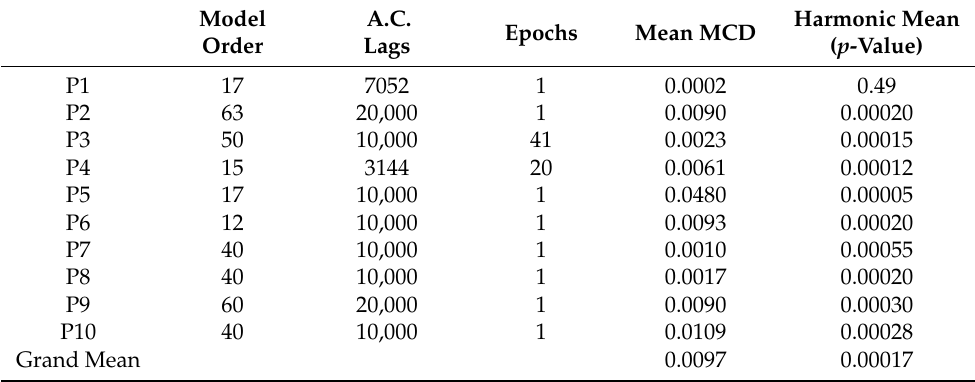
Table 3. Summary of individual model attributes. Model Order (number of autoregressive terms); Autocorrelation Lags (maximum sample lags used in calculation); Epochs (to remedy non-stationarity assumptions in two time series, data was epoched, standardized, and linearly detrended); Mean MCD (mean causal density) MCD values mathematically allow for averaging, hence values were averaged across individual MCDs for each paired time-series comparison; and Harmonic mean p-values tested against FDR-corrected α adj = 0.0292. Grand Mean MCD Harmonic Mean p -value tested against FDR-adjusted α adj = 0.0275. Harmonic Mean Model A.C. Epochs Mean MCD ( p -Value) Order Lags P1 17 7052